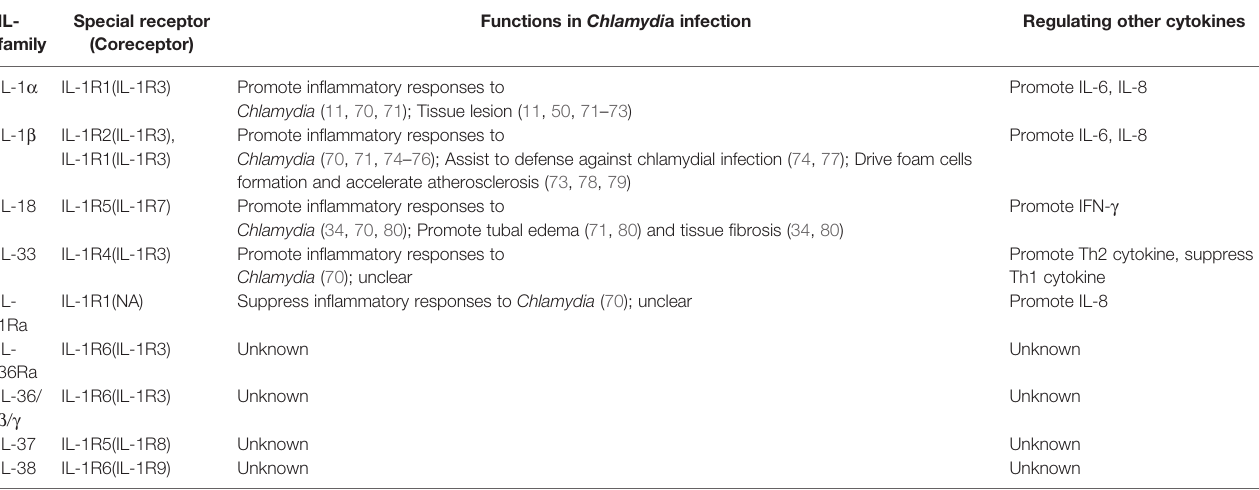
TABLE 2 | IL-1 family in Chlamydia